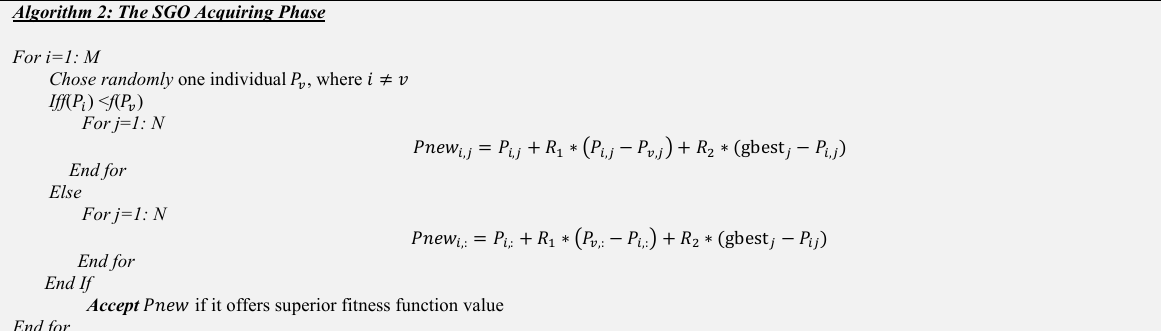
Algorithm 2: The SGO Acquiring